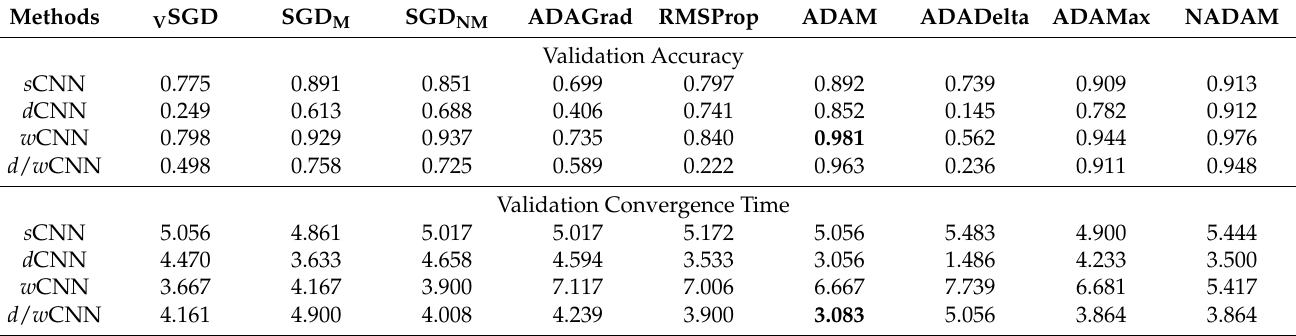
Table 9. Results of optimizers with CNN architectures on Natural Images (epoch =